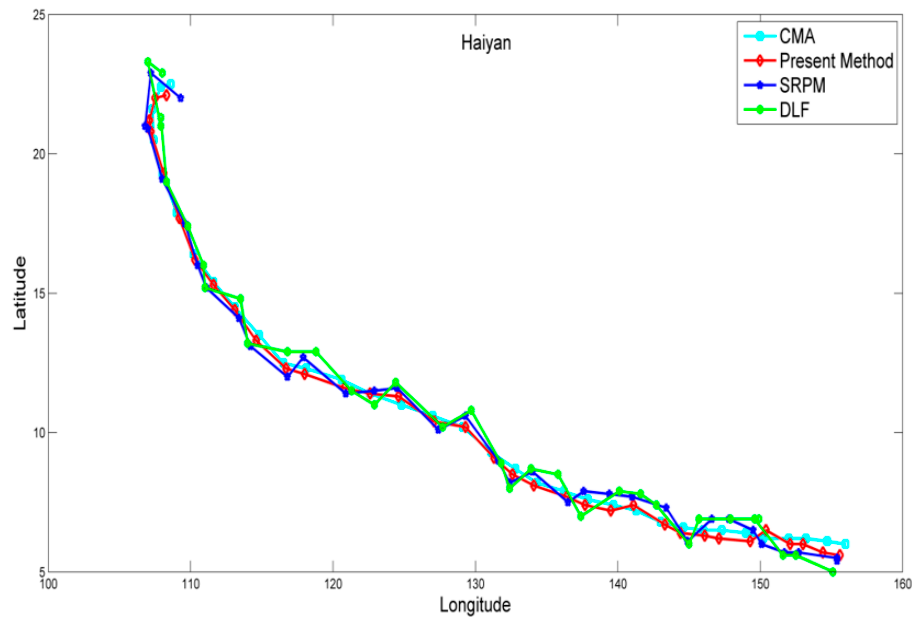
Figure 5. Comparison of different methods for Haiyan.